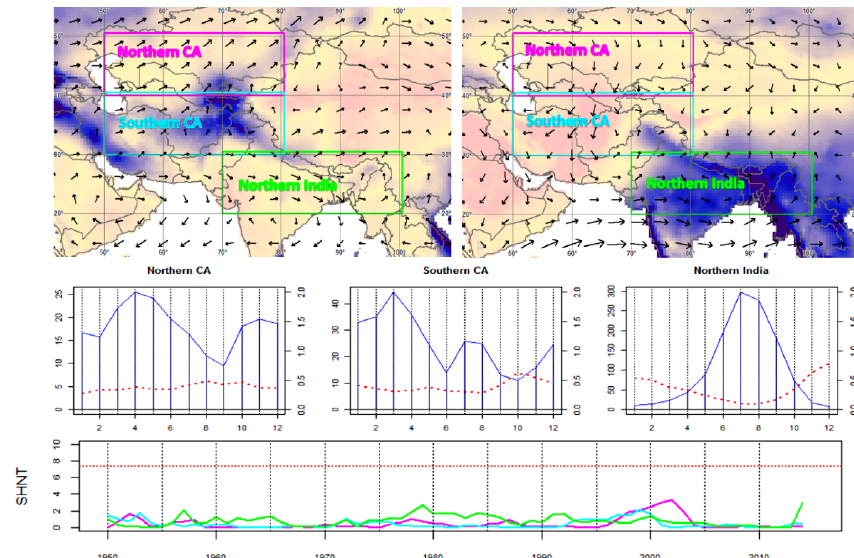
Figure 5. Location of selected target areas as well as the mean precipitation total (in millimeters) (CRU TS) and the mean 850hpa wind field (NCEP-NCAR) during DJF (left) and JJA (right). Diagrams show the mean monthly precipitation amount for every catchment in millimeters (blue bars) as well as the coefficient of variation (red line) (middle panels) and the result of the standardized normal homogeneity test. The red line indicates the 0.95 significance level (lower